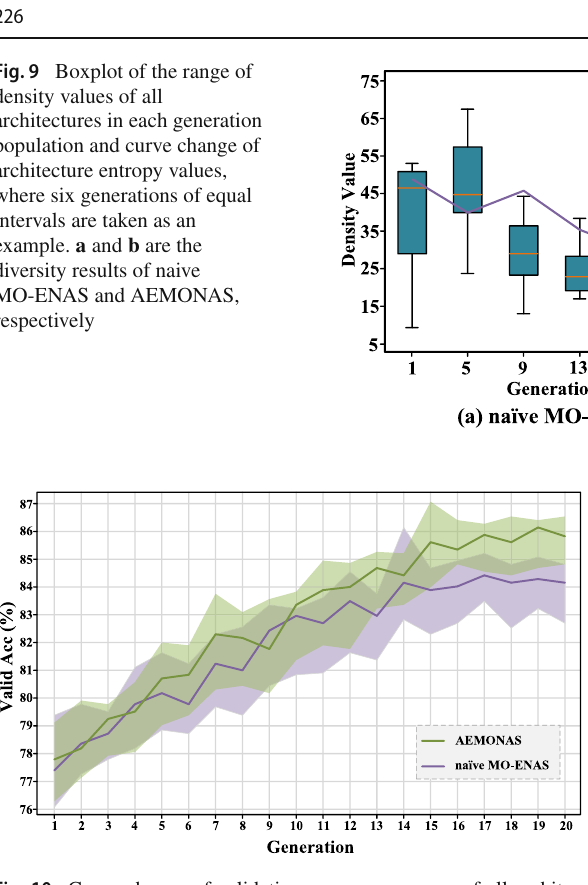
Fig. 10 Curve change of validation average accuracy of all architec- tures in each generation of population during the search process of AEMONAS and naive MO-ENAS, and the light-colored part represents the upper and lower limits of the validation accuracy